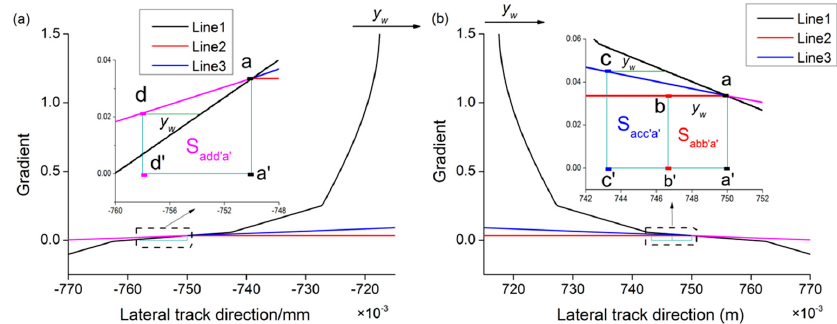
Figure 3. Wheel-rail contact with different wheel profile gradients, without considering rolling angle. ( a ) Left wheel-rail; ( b ) Right wheel-rail.